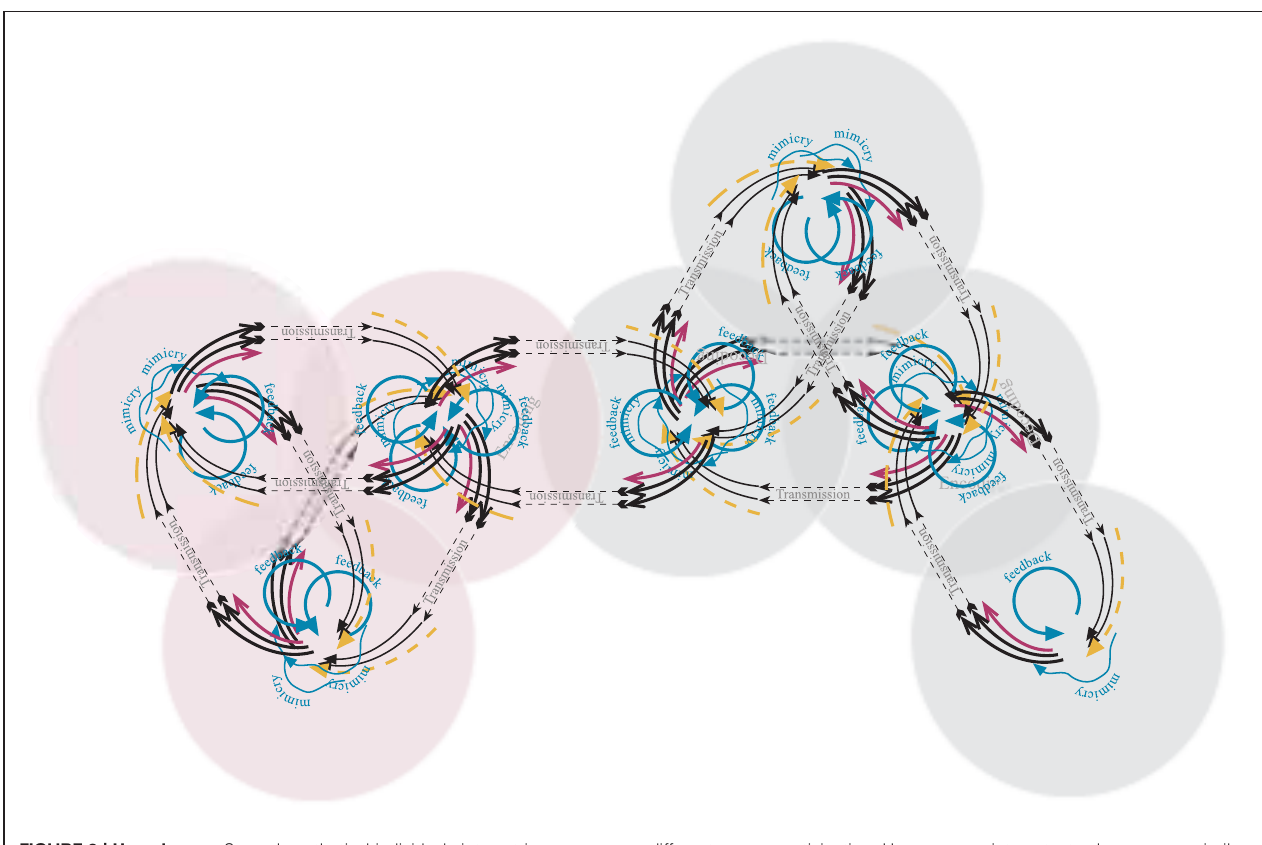
FIGURE 3 | Hyperlenses. Seven hypothetical individuals interact in a communication structure that involves several dyads and triads—for example in the context of a party. The color of the context circle suggests here two